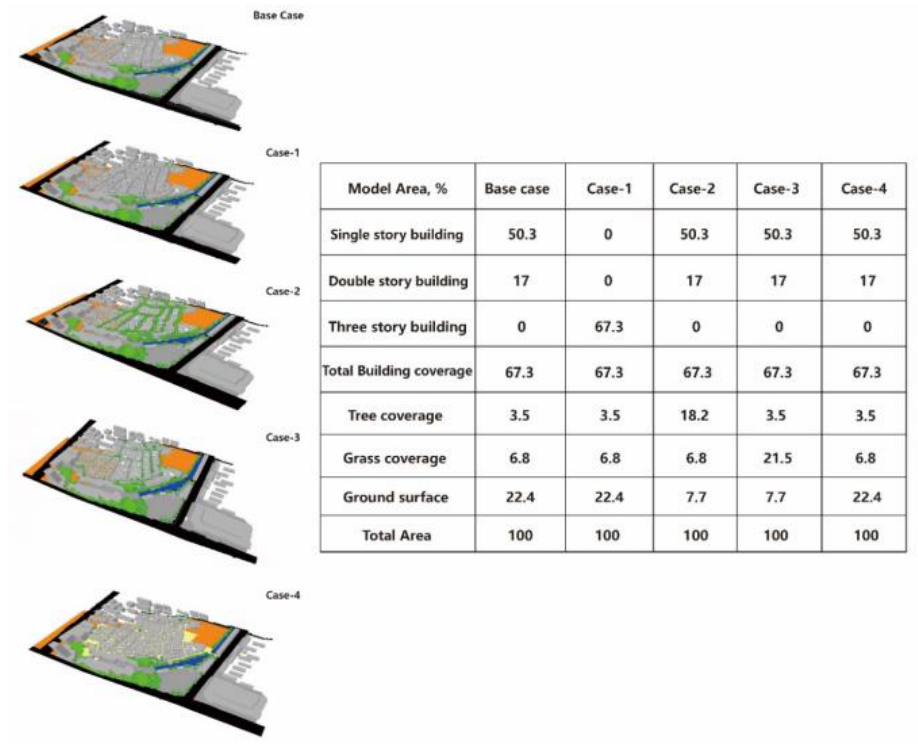
Figure 14. Various types of parameters in new configurations.